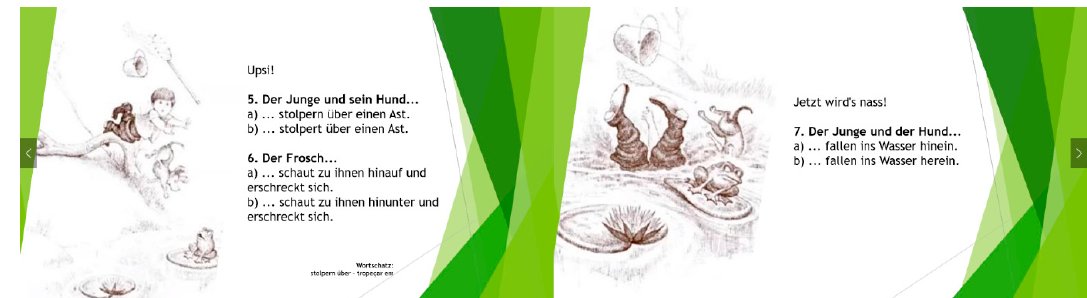
Figure A16. Pretest: Binary-choice recognition task.